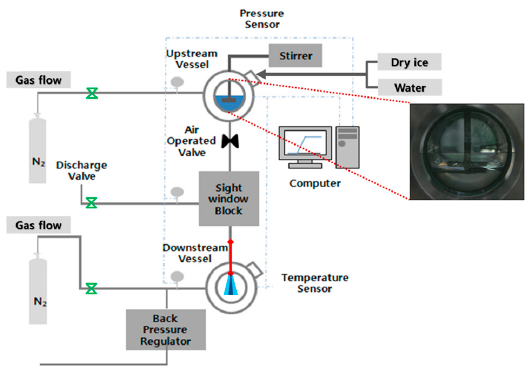
Figure 1. Schematic of experimental setup.